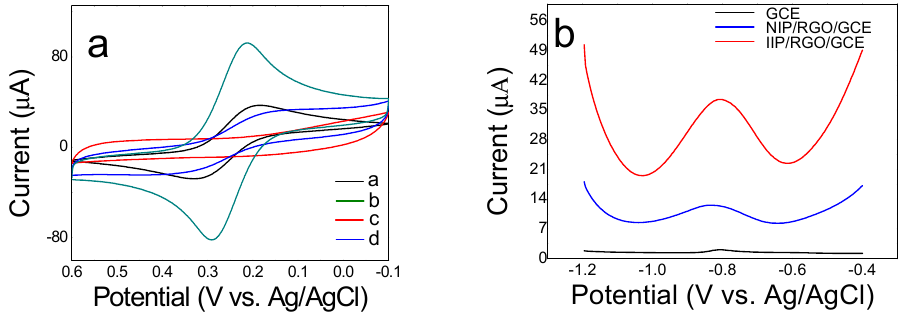
Figure 8. ( a ) CV curves on bare GCE (curve a), ERGO / GCE (curve b), Cd(II)-IIP / ERGO / GCE (curve c), and IIP / ERGO / GCE (curve d) between -0.2 V and 0.6 V at a scan rate of 50 mV / s in 5 mM K 3 [Fe (CN)] 6 solution, ( b ) SWASV curves on bare GCE, NIP / ERGO / GCE and IIP / ERGO / GCE in 10 ng / mL Cd(II) standard solution.